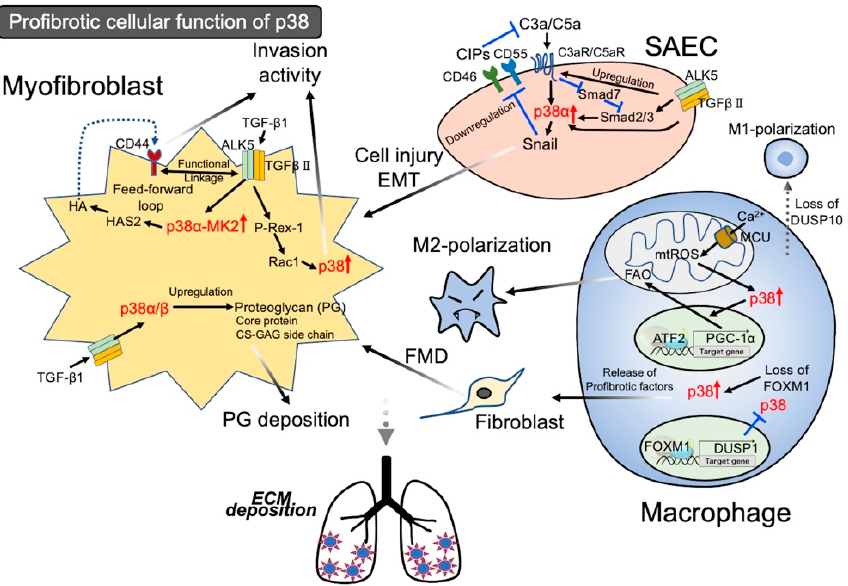
Figure 3. The molecular mechanism of p38-mediated pulmonary fibrosis. p38 participates in various cellular responses to profibrotic stimuli: EMT and cell injury of small airway epithelial cell (SAEC), invasion capacity and PG deposition of a myofibroblast, and M2 polarization and FMD promotion of a macrophage. Loss of DUSP10 leading to p38 activation seems to mediate the antifibrotic cellular functions. A more detailed evaluation regarding this point remains to be elucidated.